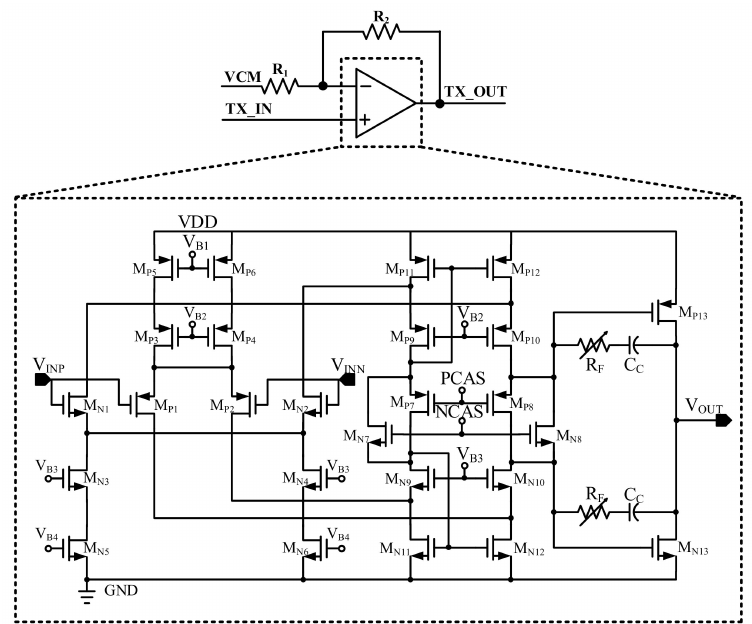
Figure 13. Transmitter